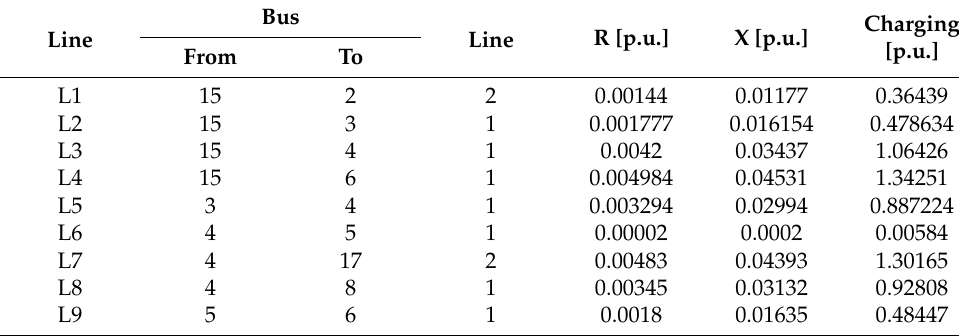
Table A5. The line data of ISGHV (400